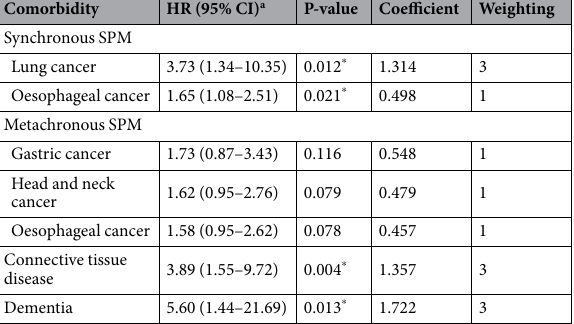
Table 4. Cox proportional hazards analysis of comorbidities as prognostic factors for overall survival in patients with head and neck squamous cell carcinoma in the training set. * P < 0.05. a HRs were adjusted for age, primary tumour site, sex, Karnofsky performance status, and clinical stage. CI, confidence interval; HR, hazard ratio; SPM, second primary